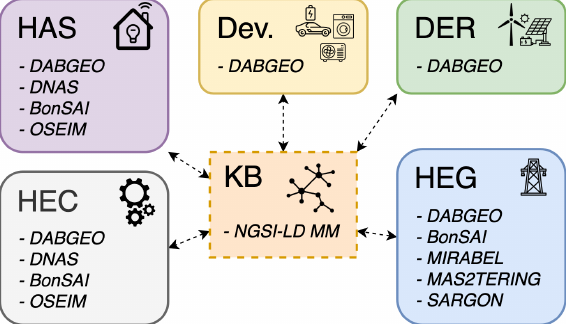
Figure 3. Knowledge Base-centred architecture of the Smart Home Energy Management